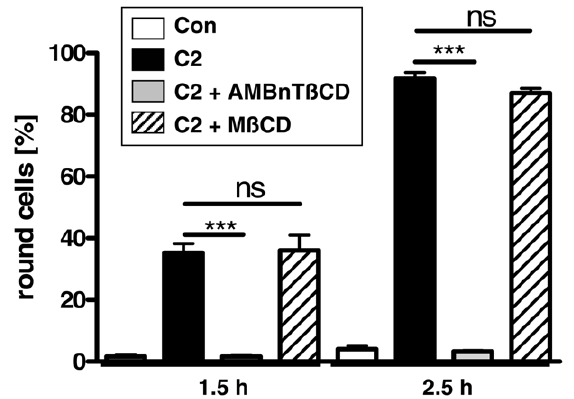
Figure 2. The ß-cyclodextrin derivative AMBnTßCD but not methyl-ß-cyclodextrin protects Vero cells from intoxication with C2 toxin when administered at 10 m M final concentration. Vero cells grown in 24-well plates were treated for 1 h at 37 u C with either AMBnTßCD (10 m M) or methyl-ß-cyclodextrin (MßCD, 10 m M) and subsequently cells were challenged with C2 toxin (200 ng/ml C2IIa + 100 ng/ml C2I). After 1.5 and 2.5 h of incubation at 37 u C, pictures were taken to determine the percentages of round cells. Values are given as mean 6 S.D. (n=3) and significance was tested for each time point between toxin-treated samples and samples treated with either AMBnTßCD plus C2 toxin or MßCD plus C2 toxin by using the student’s t-test (***p , 0.0005; n. s.=not significant).